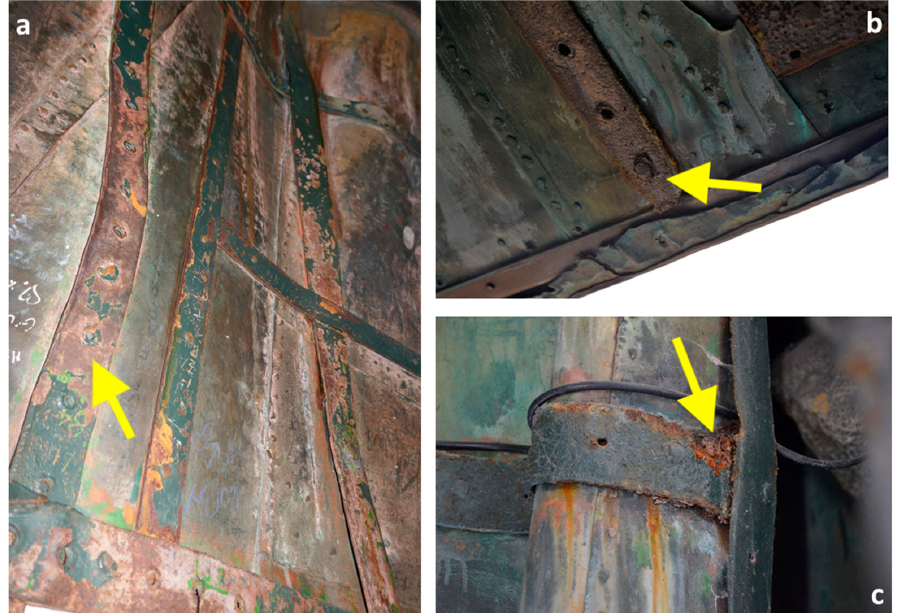
Figure 2. Examples of degradation patterns on iron elements. ( a ) Iron bars in good conservation conditions despite the degradation of the protective coating; ( b , c ) small areas characterised by severe corrosion surrounded by almost intact zones.